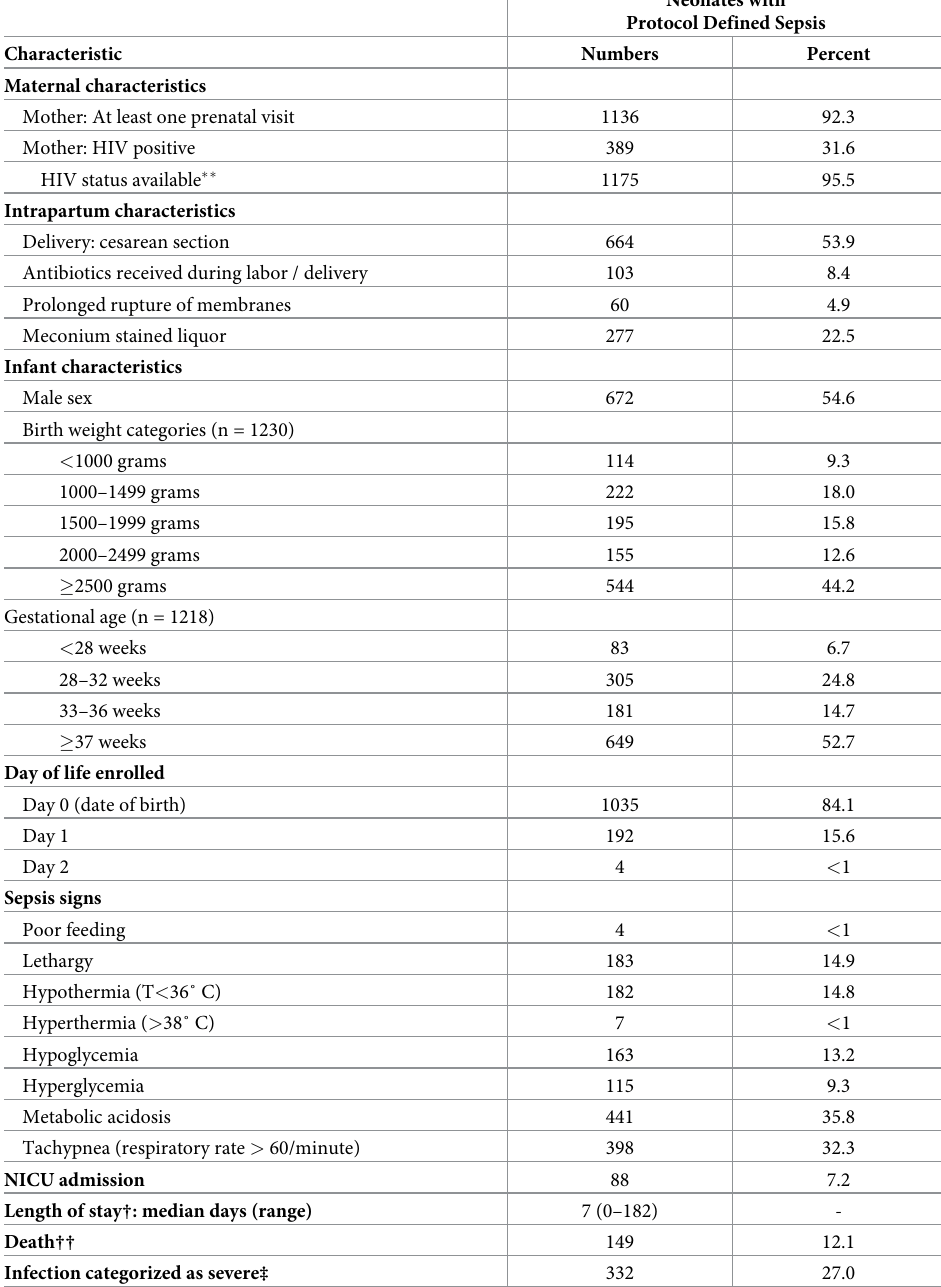
Table 1. Characteristics of infants meeting case definition � for protocol-defined early-onset sepsis (n = 1,231)— SANISA Study: Soweto, South